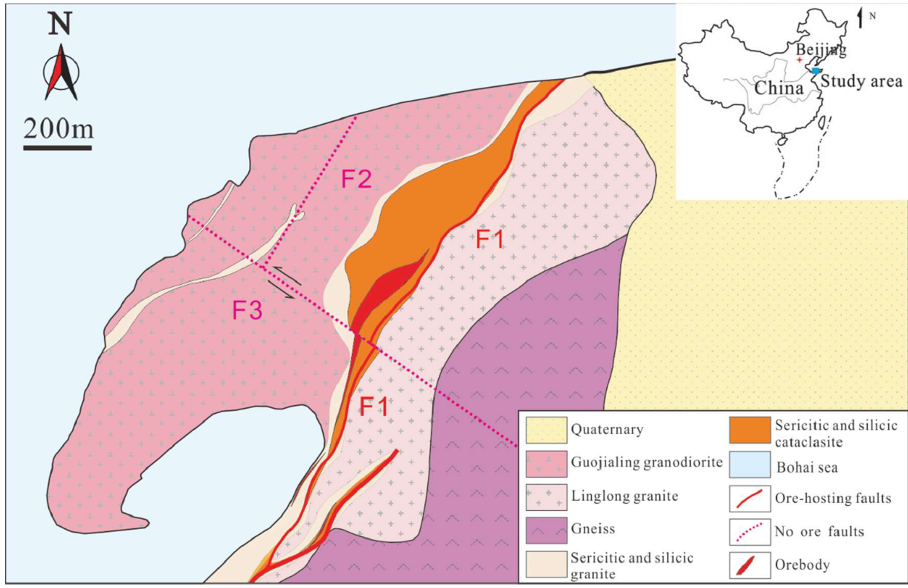
Figure 1. Geological map of the Sanshandao gold mine.